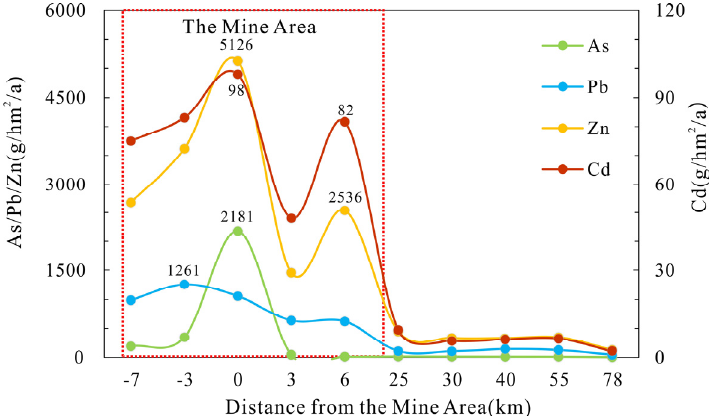
Figure 4. Spatial migration of heavy metals in the atmosphere. (Changes in the concentration of heavy metals migrating along the